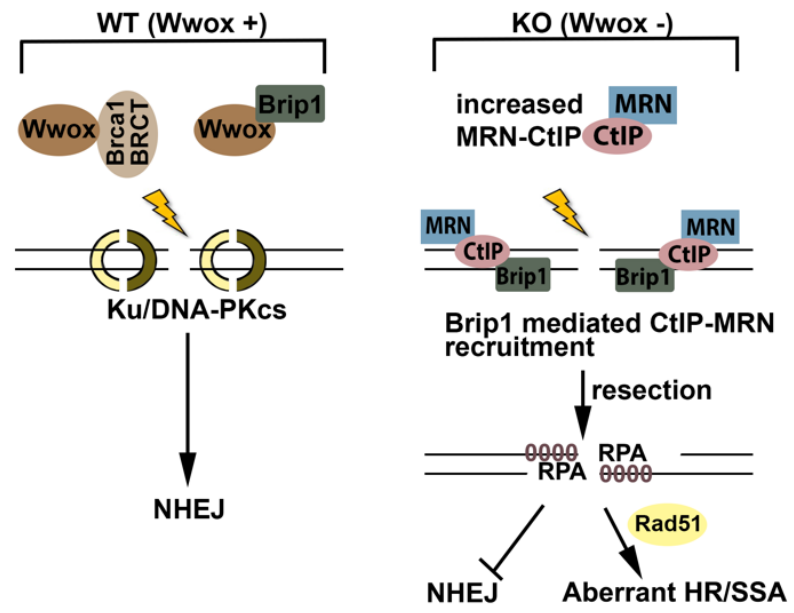
Figure 6. Proposed model illustrating Wwox role in repair of DSBs immediately following IR or platin exposure. In cells expressing Wwox, Wwox binding to BRCT blocks Brca1-BRCT complex formation and BRCA1 activation; Wwox-Brip1 interaction inhibits Brip1 mediated CtIP-MRN recruitment to DSBs. In the absence of Wwox, both Brca1-BRCT and Brip1 proteins are more accessible for interaction with CtIP and MRN complex even without IR. The pre-formed MRN-CtIP complex is rapidly recruited to DSBs by Brip1 and initiates resection immediately, which inhibits NHEJ and promotes HR/SSA repair. These repairs are mutagenic causing IR/Platinum resistance.